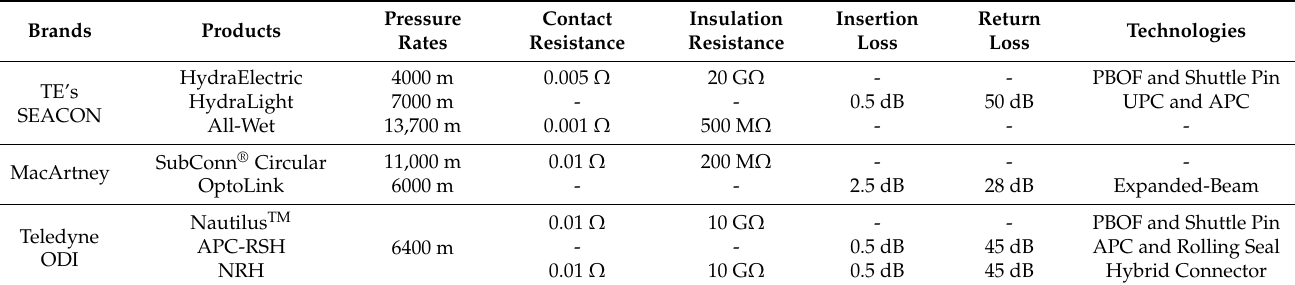
Table 1. Main specifications of some first-class WMCs of globally famous